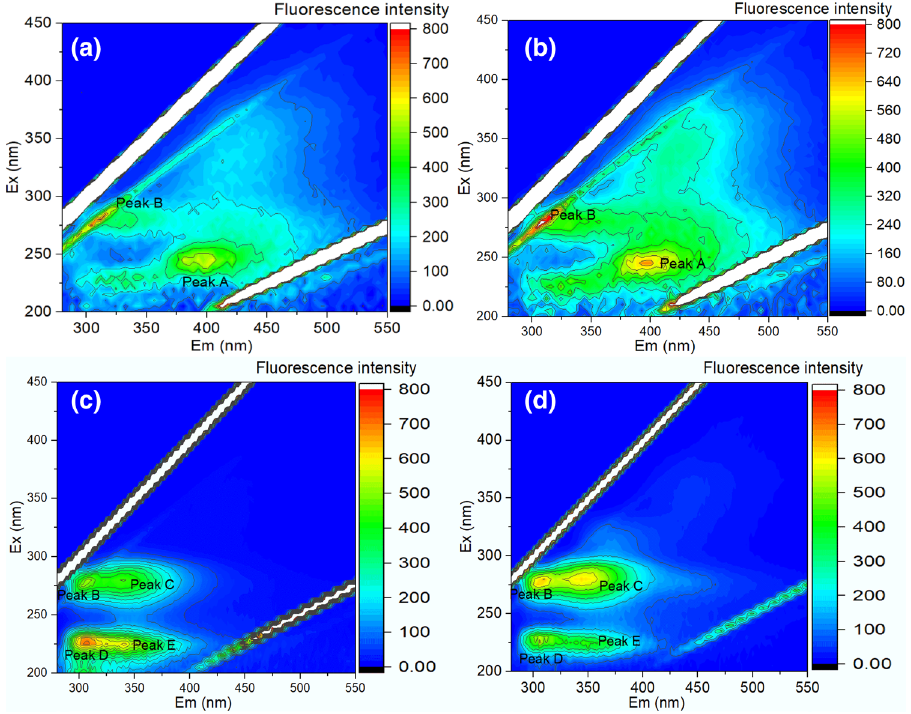
Figure 5. 3D-EEM spectra of EPS extracted from ( a ) initial sludge and ( b ) 15 V, ( c ) 25 V, ( d ) 35 V dewatered sludge.